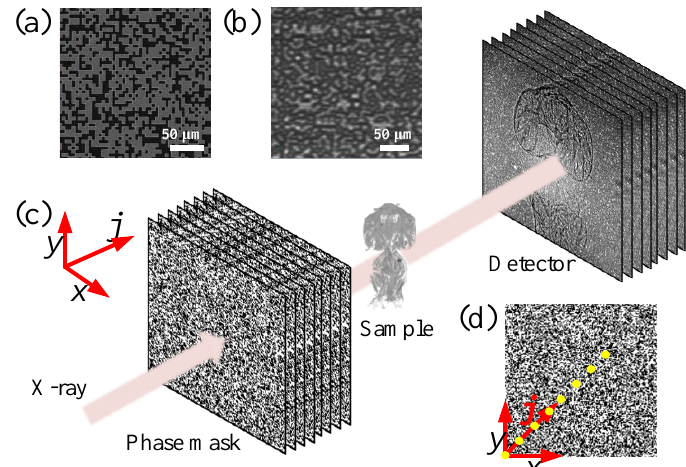
Figure 1. ( a ) SEM image of an example coded phase mask. ( b ) X-ray transmission image of a coded phase mask. ( c ) Schematic of the scanning CMMI experimental setup. ( d ) Diagram showing the linear scanning pattern of the coded phase mask along its diagonal direction. Note that the spacing between dots in ( d ) is not to the actual